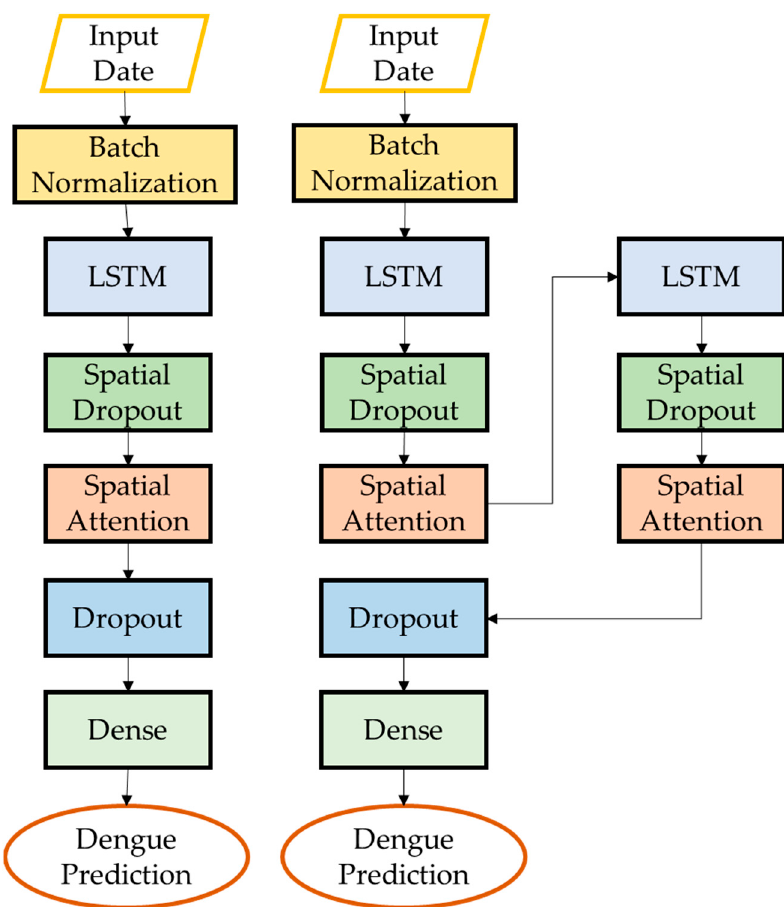
Figure 7. Architecture of SA-LSTM and SSA-LSTM.